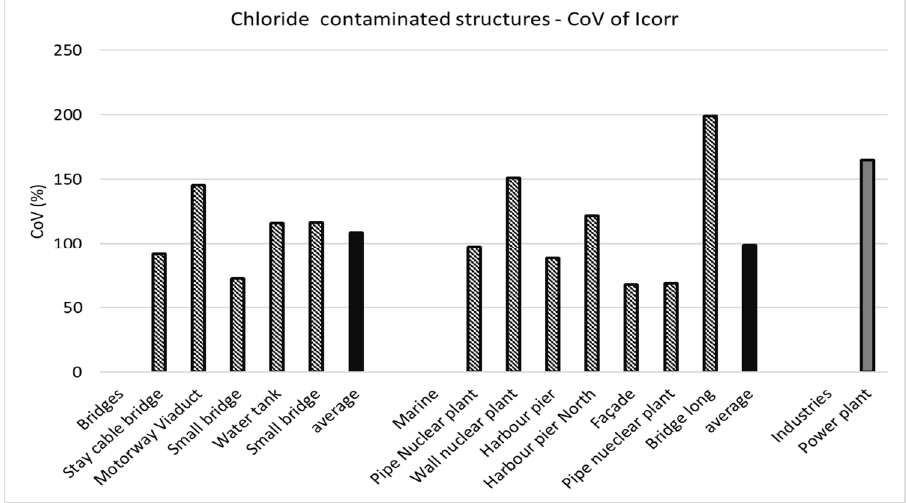
Figure 4. Average values the coefficient of variation in different structures contaminated by chlorides.